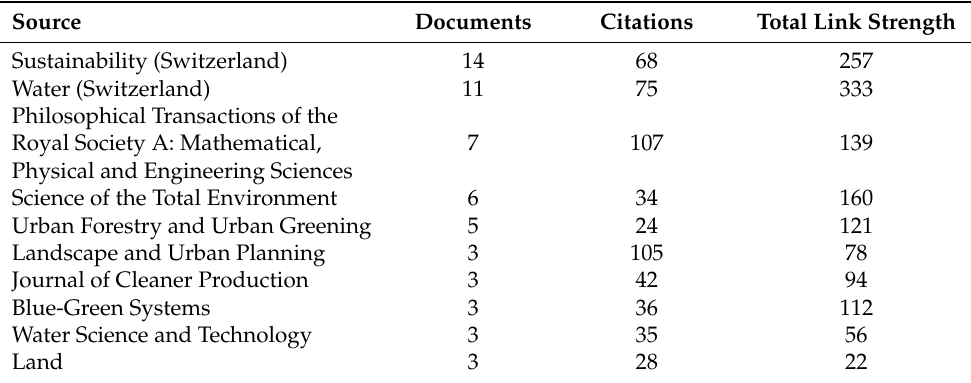
Table 2. Distribution of the documents based on sources of